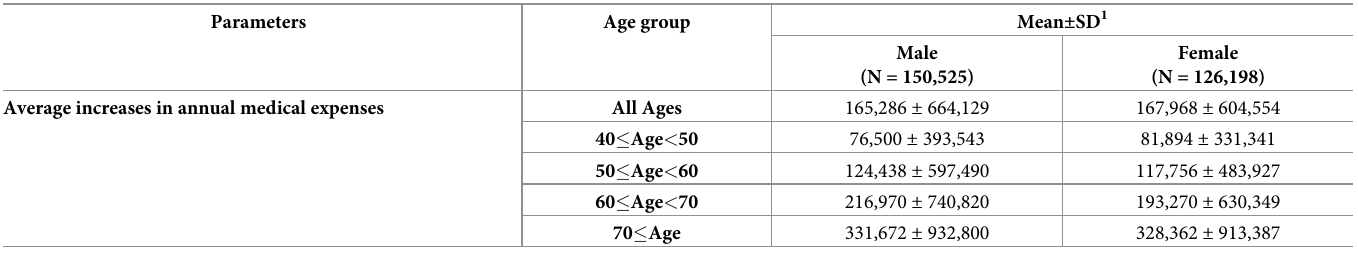
Table 5. Average annual increases in medical expenses by gender and age group.